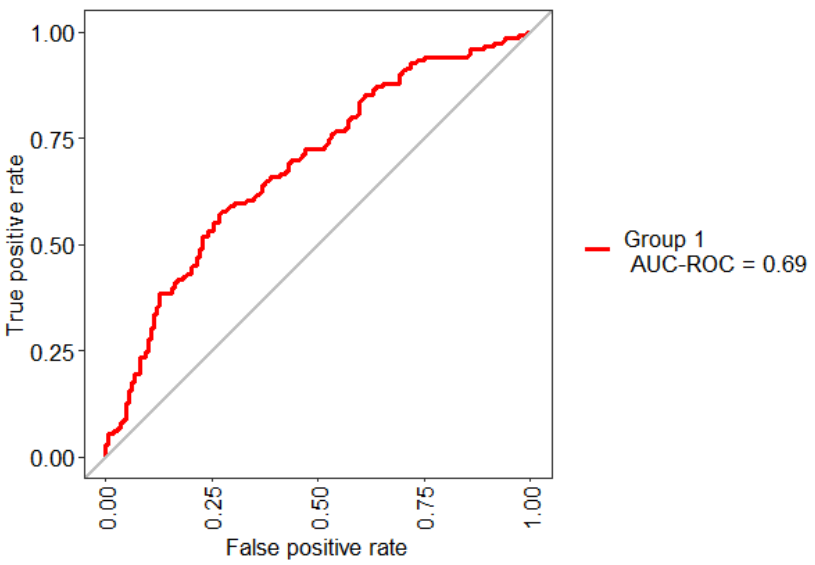
Figure 3. ROC curve obtained for the model based on the key features identified by Boruta.